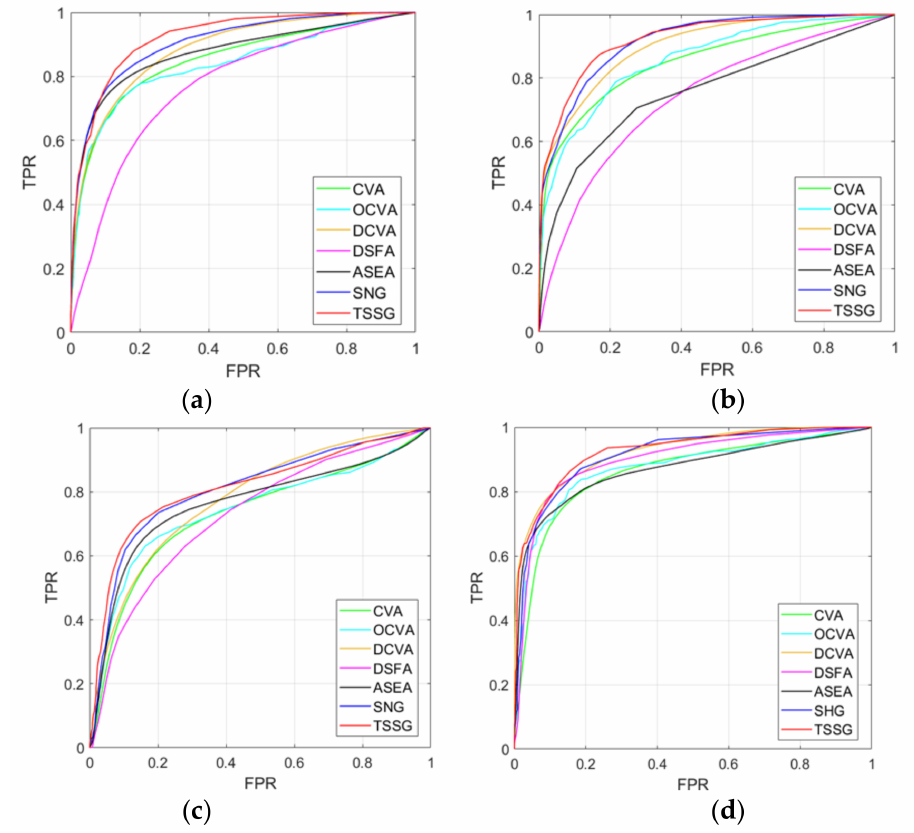
Figure 10. ROC curves of different methods on the four data sets: ( a ) Mingfeng; ( b ) SZTAKI; ( c ) The first patch sample of B&T data set; ( d ) The second patch sample of B&T data